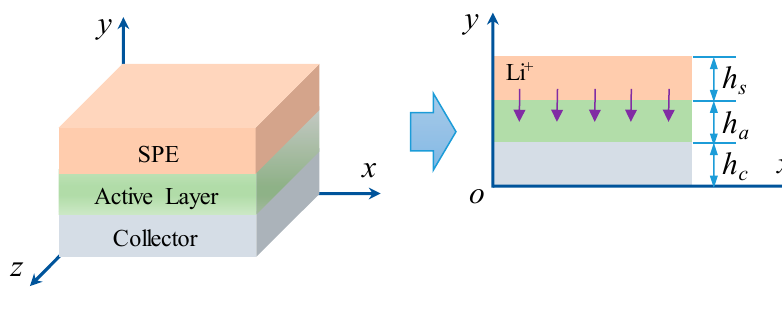
Figure 3. Schematic of the model geometry.